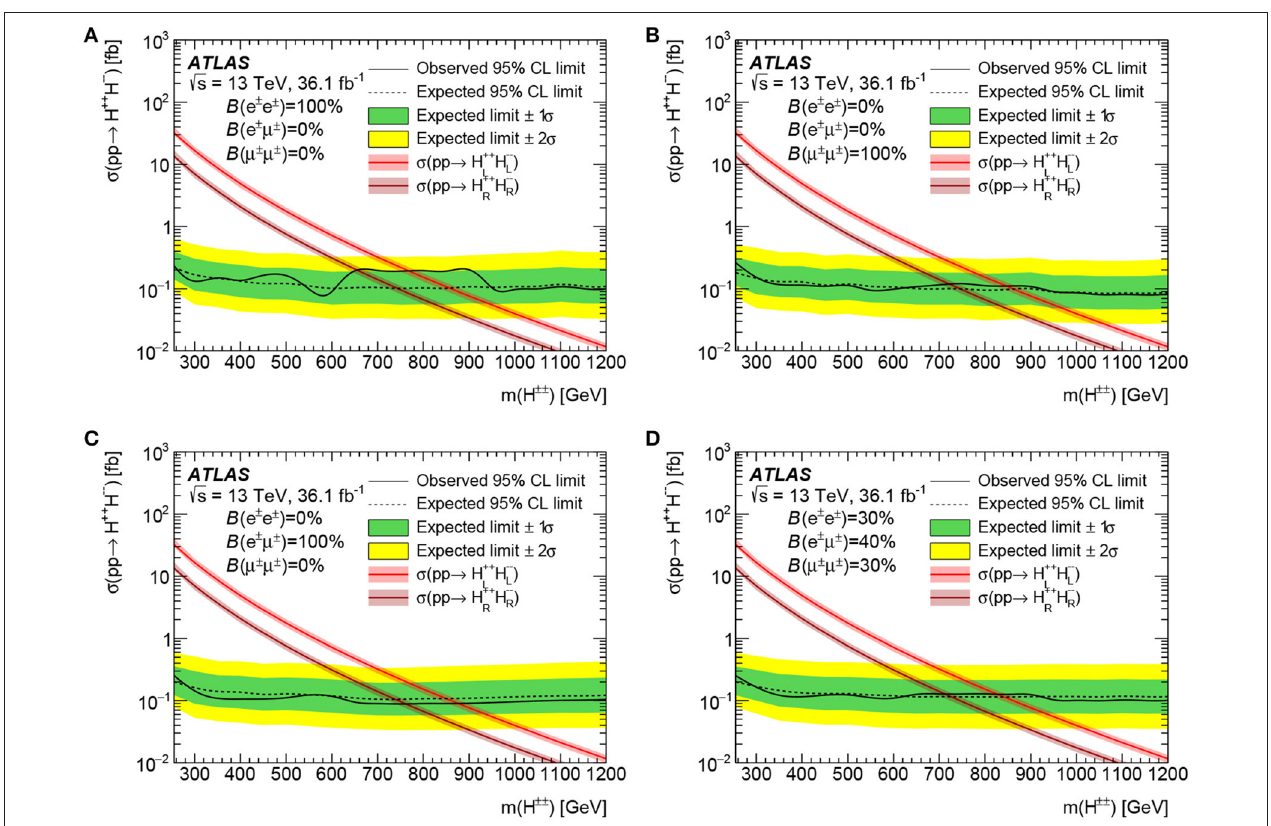
H ++ H −− ) for various representative branching rates to SM charged leptons in the 36 fb − 1 on σ ( pp = →